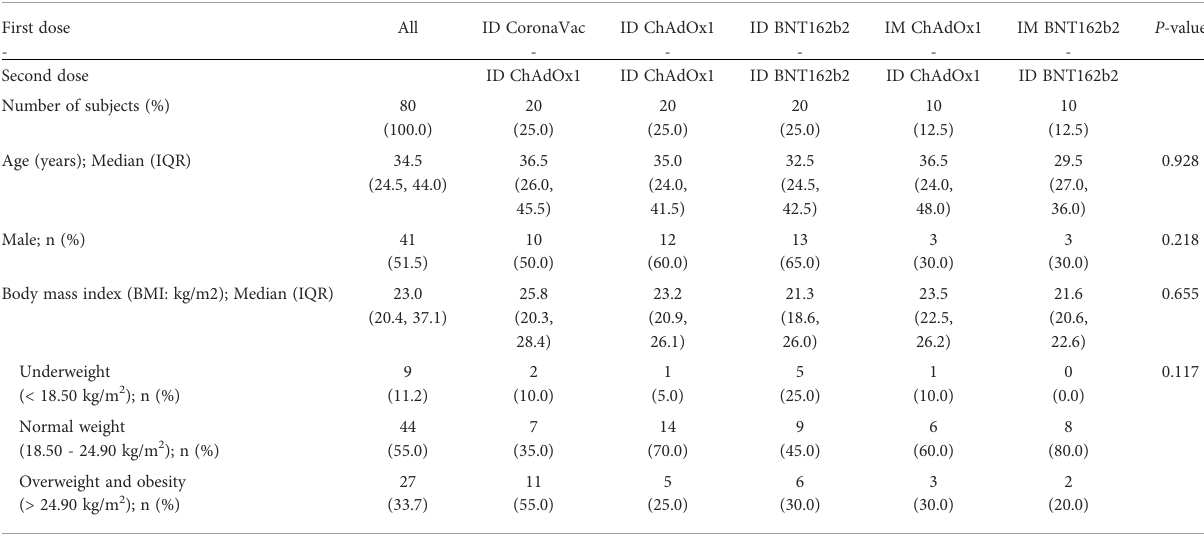
TABLE 1 Baseline characteristics of the subjects by routes and types of COVID-19 vaccines in fi rst and second